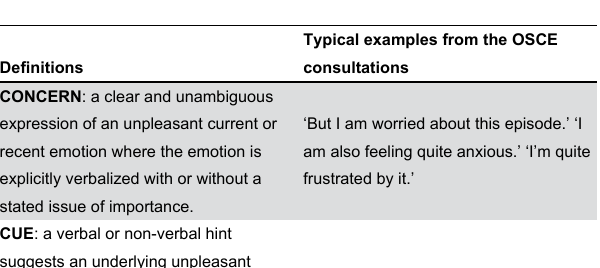
Table 1. Definitions of cues and concerns and examples from the OSCE *